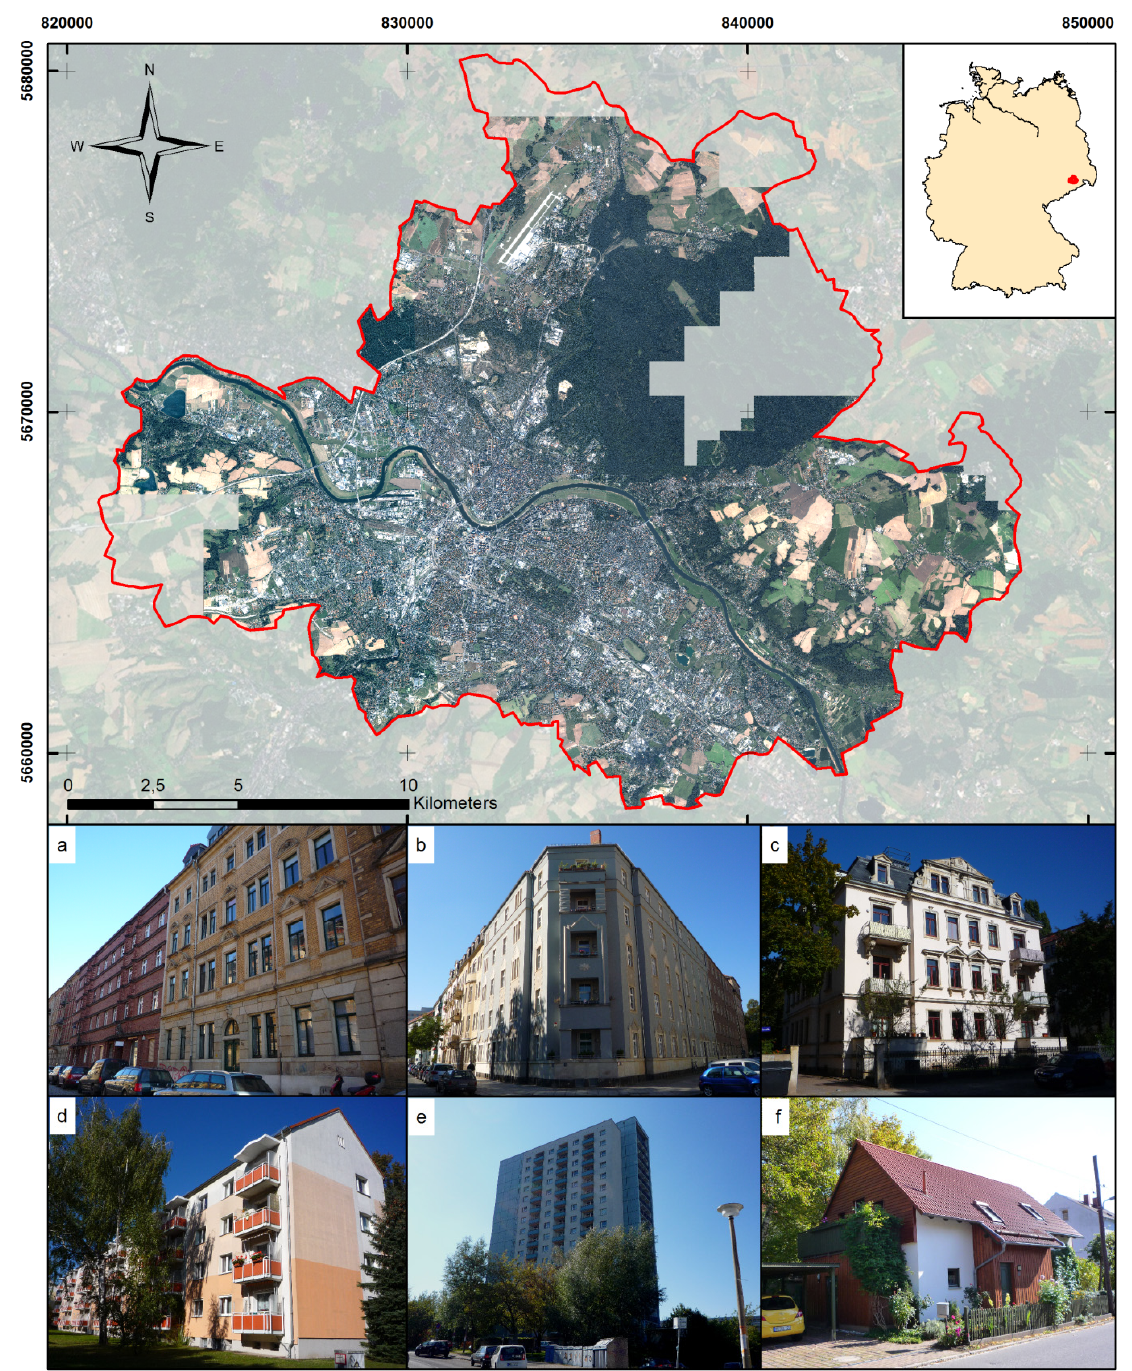
Figure 1. Ikonos imagery of the study area Dresden, Germany (projection: WGS 84 – UTM Zone 32N). Photographs of residential building types in Dresden: ( a ) Buildings of the historic city center; ( b ) Closed block development; ( c ) 4-Story villa (so-called “Würfelhäuser”/“Kaffeemühlenhäuser”); ( d ) Mid-rise dwellings; ( e ) High-rise building (“Plattenbau”); ( f ) Singe-family